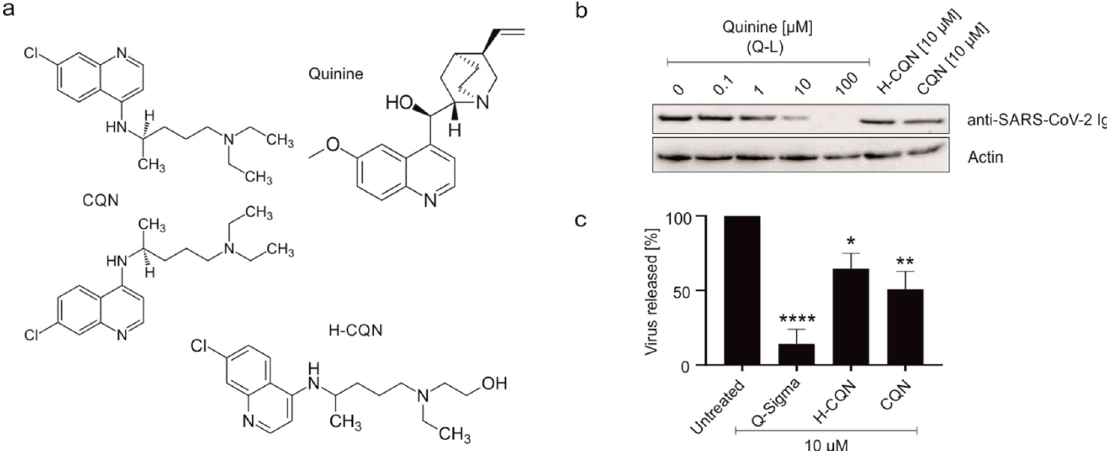
Figure 1. Influence of quinine, H-CQN, and CQN on the replication of SARS-CoV-2 in Vero B4 cells. ( a ) Molecular structures of quinine, H-CQN, and CQN. ( b ) Western blot analysis of virus fractions (anti-SARS-CoV-2 Ig). The cell fractions were stained with ß-actin antibody. Quinine-sulfate was used as ( b ) Q-L or ( c ) Q-S. Cell culture supernatants were harvested at 3 d post-infection (dpi). The virions were purified and analyzed by Western blot using a SARS-CoV-2 convalescent serum. ( c ) Densitometric analysis of Western blot analysis was performed using AIDA ® . Analysis of five independent experiments ± standard deviation (SD) (Q-S **** p < 0.001 using a one-sample t -test), three independent experiments ± SD (H-CQN * p = 0.0270), or four independent experiments (cid:3399) SD (CQN ** p = 0.0039).